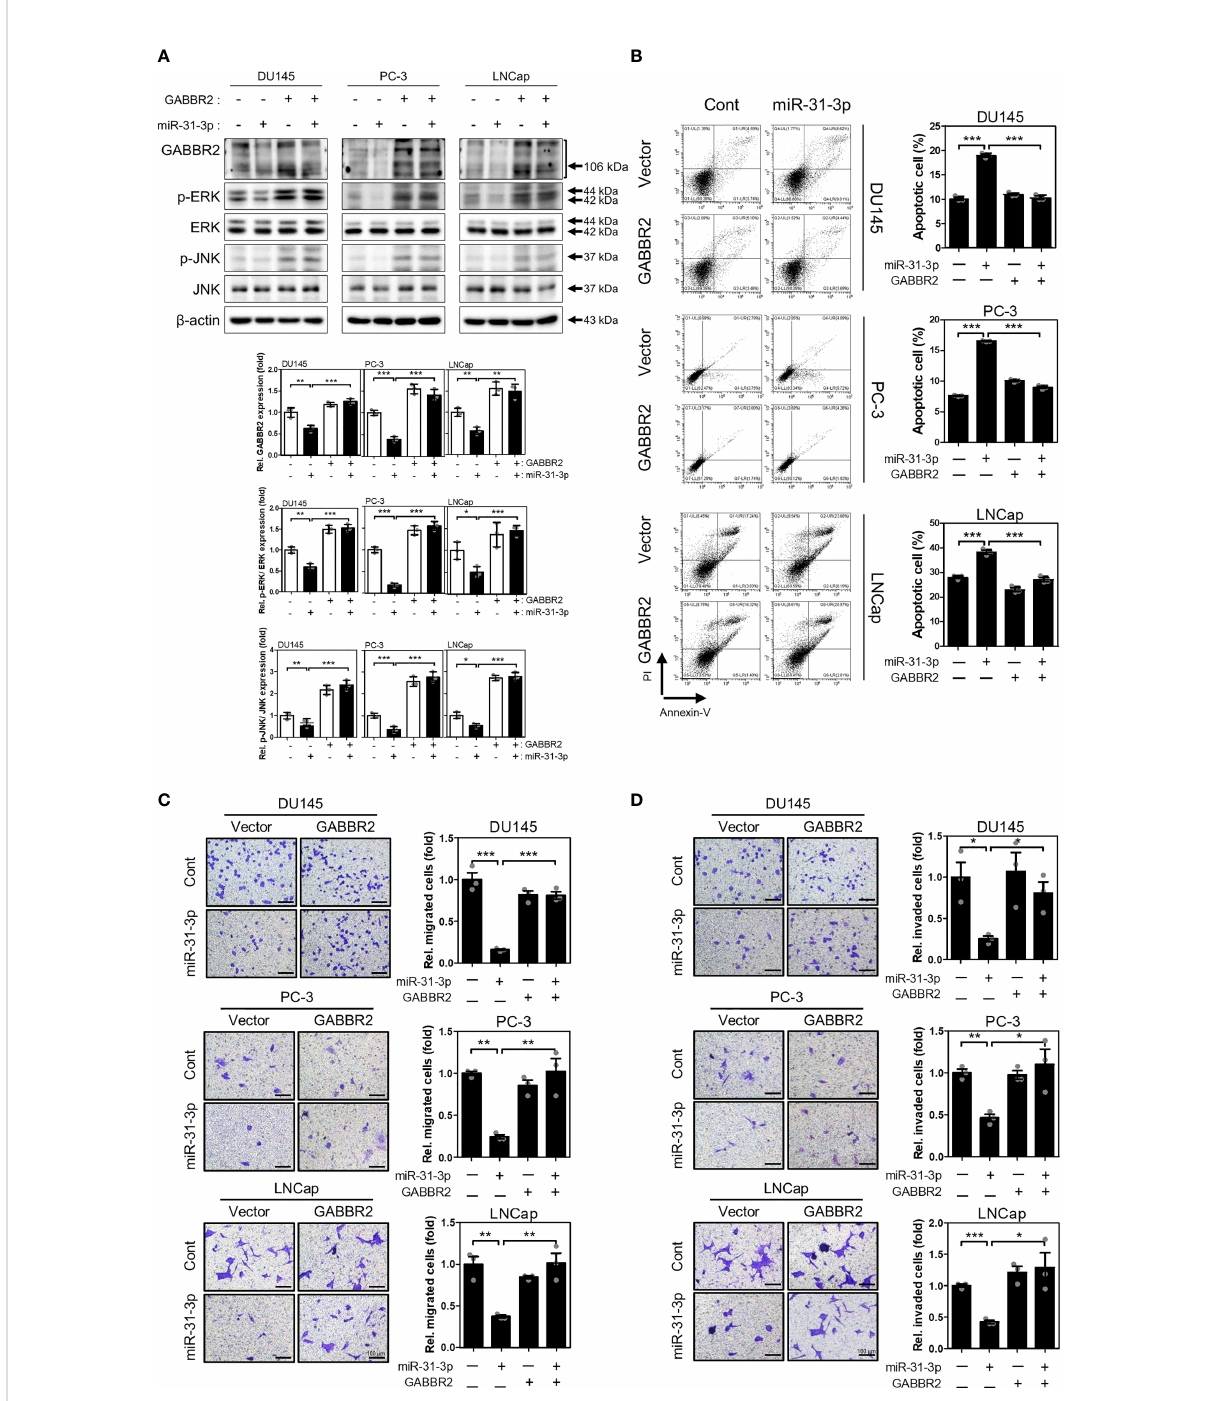
FIGURE 4 miR-31-3p-induced tumor suppressive functions are associated with downregulation of GABBR2 . (A) Restoration of GABBR2, p-ERK and p-JNK protein levels after ectopic expression of Myc-DDK-tagged-GABBR2. DU145, PC-3 and LNCap cells were transfected with a mixture of miR-31- 3p (20 nM) and GABBR2 expression vector (4 m g). An unpaired two-tailed Student ’ s t -test was used to calculate P values. Error bars represent mean ± SEM. *P value < 0.05, **P value < 0.01 and ***P value < 0.001 vs. Cont (n = 3). (B) Ectopic expression of GABBR2 suppresses miR-31- 3p-induced apoptosis of DU145, PC-3, and LNCap cells. An unpaired two-tailed Student ’ s t -test was used to calculate P values. Error bars represent mean ± SEM. ***P value < 0.001 vs. Cont (n = 3). (C, D) Ectopic expression of GABBR2 restores miR-31-3p-mediated inhibition of PC cell migration and invasion. An unpaired two-tailed Student ’ s t -test was used to calculate P values. Error bars represent mean ± SEM. *P value < 0.05, **P value < 0.01 and ***P value < 0.001 vs. Cont (n =